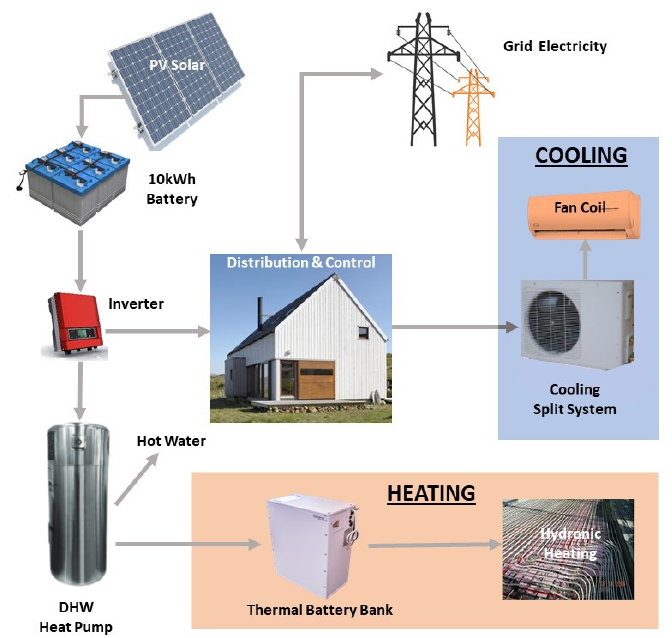
Figure 1. Energy flows in the electrical, heating and cooling systems.